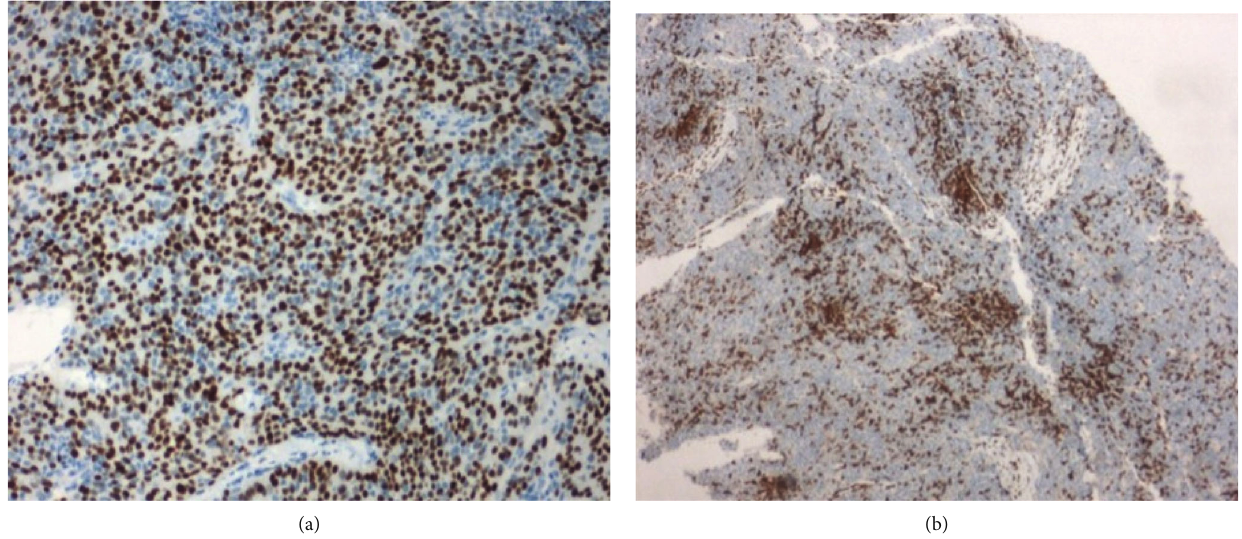
Figure 5: (a) Tumour cells show positive staining for p63 ( × 40). (b) CD5 shows patchy positive cells ( ×